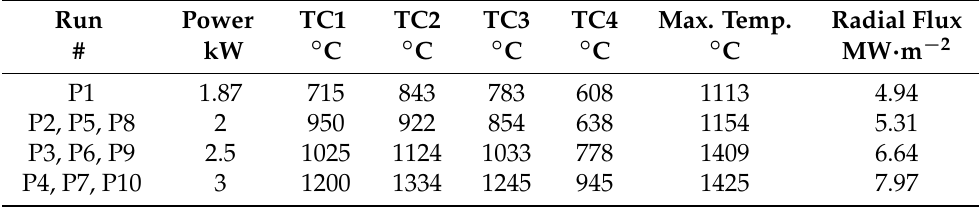
Table 5. Measured and computed temperatures for different runs.